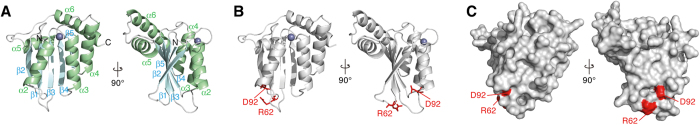
Structure modeling of bovine A3Z3.Cartoon (A,B) and surface (C) models of the structure of cattle A3Z3 are shown. In (A) α-helices and β-sheets are shown in green and pale blue, respectively. In (A,B) Zn2+ is represented as a gray sphere. In (B,C) the positively selected amino acids (residues 62 and 92) are represented in red. Note that the α1 domain, including residue 32, is not shown, because residues 1–54 were not reconstructed by structure homology modeling.